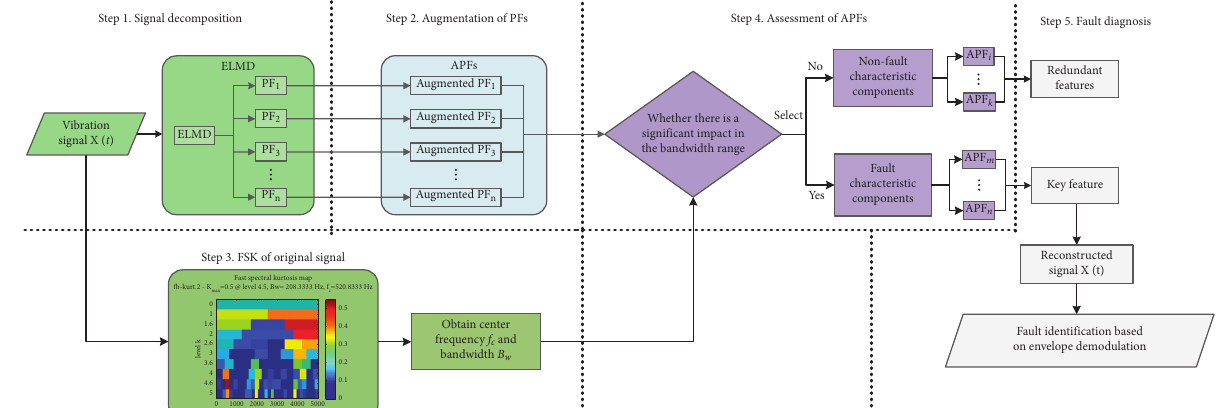
Figure 1: The architecture and flowchart of the proposed method.